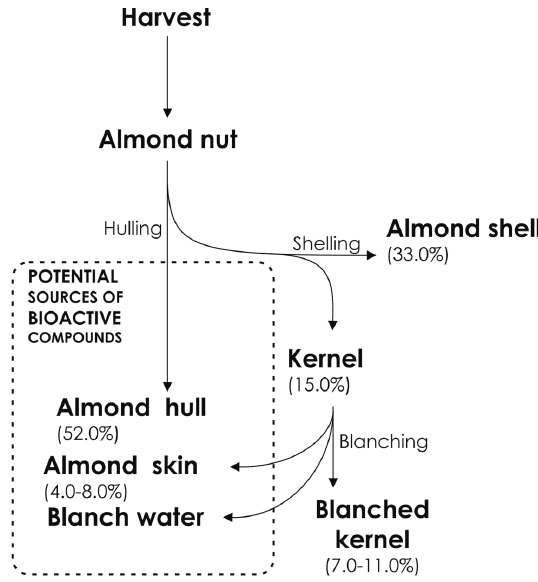
Figure 2. Process of obtaining almond by-products in the almond industry.